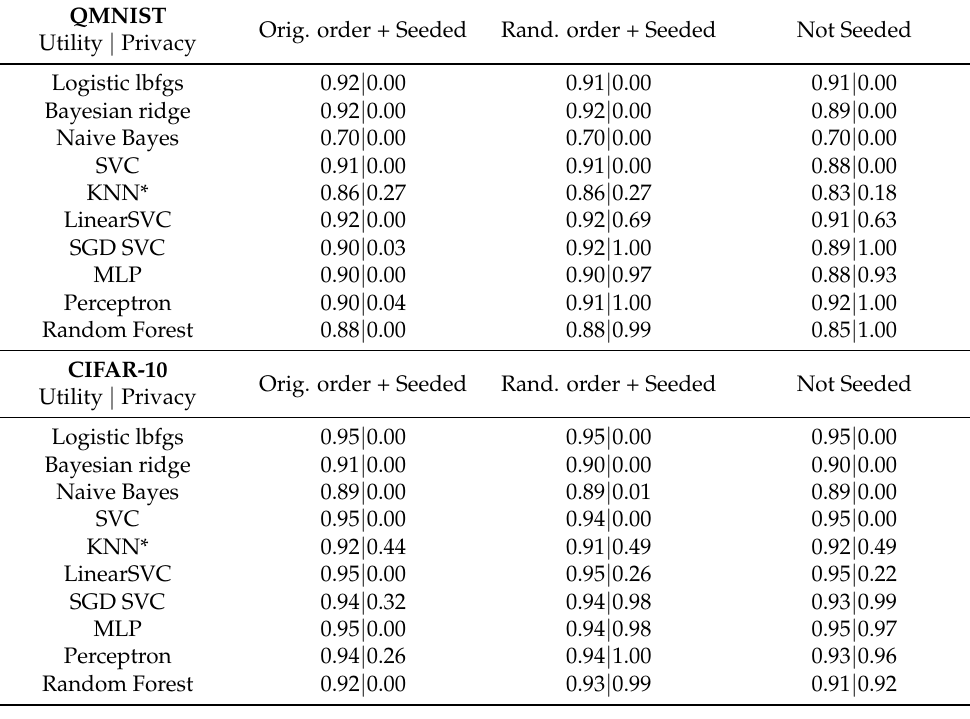
Table 1. Utility and privacy of QMNIST and CIFAR-10 of different scikit-learn models with three levels of randomness: original sample order + fixed random seed (no randomness); random sample order + fixed random seed; random sample order + random seed. The Defender data and Reserved data have both 1600 examples. All numbers shown in the table have at least two significant digits (standard error lower than 0.004). For model implementations, we use scikit-learn (version 0.24.2) with default values. Shaded in gray: fully deterministic models with Privacy ≡ 0.